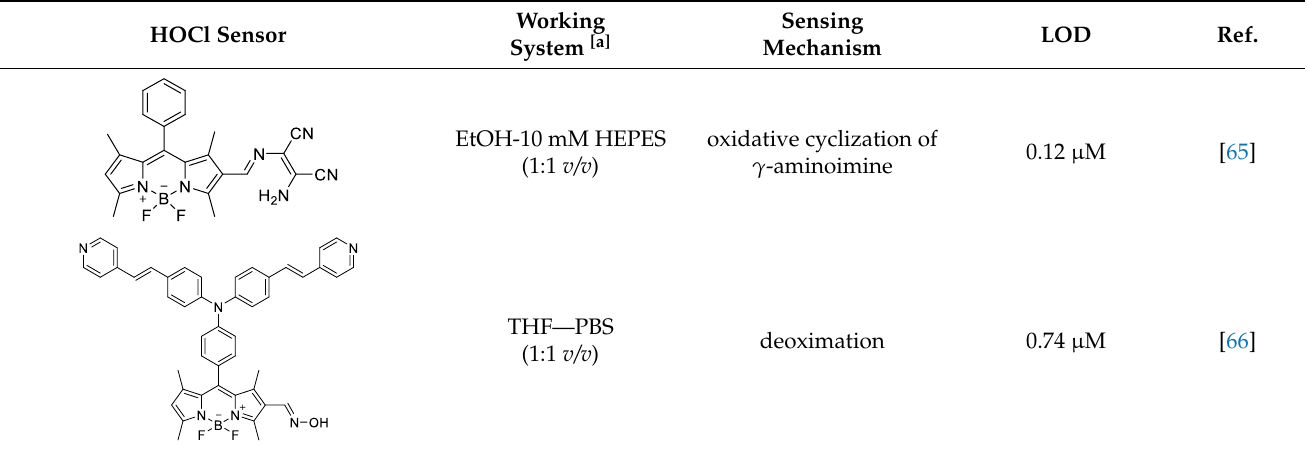
Table 2. Comparison of BODIPY-based sensors (compounds 2 and 3 ) developed in this work with the recently reported BODIPY-based fluorescence sensors for HOCl/ClO - determination in the literatures. Working Sensing HOCl Sensor LOD Ref. System [a] Mechanism